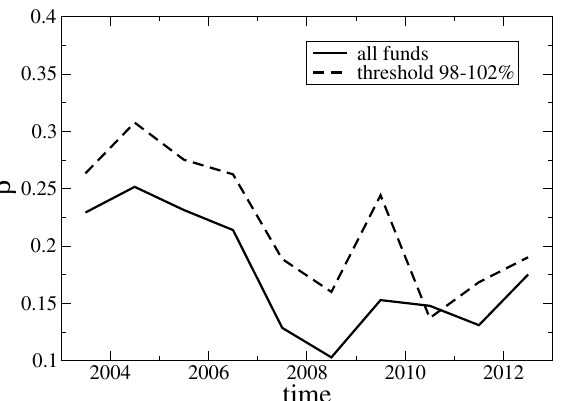
Figure 3. Time dependence of size-variance exponent. β The values of the slope of the least square fit of the size-variance relationship over the entire range of ln S from 15 to 23 for different years obtained for all observations and only for the observations for which the percentage of stock holdings is between 98 and 102%. The values of the slope fluctuate similarly for both methods reaching the minimum during the crisis and recovery period.